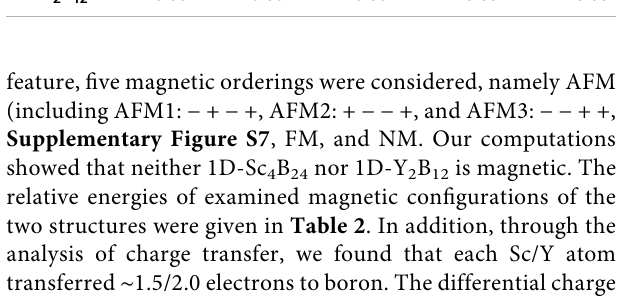
Frontiers in Chemistry |